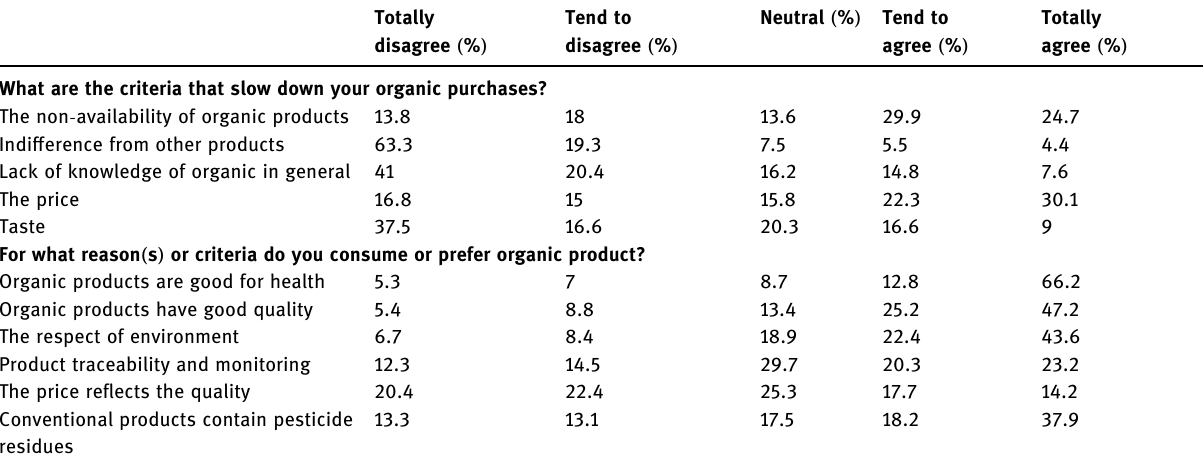
Totally Tend to